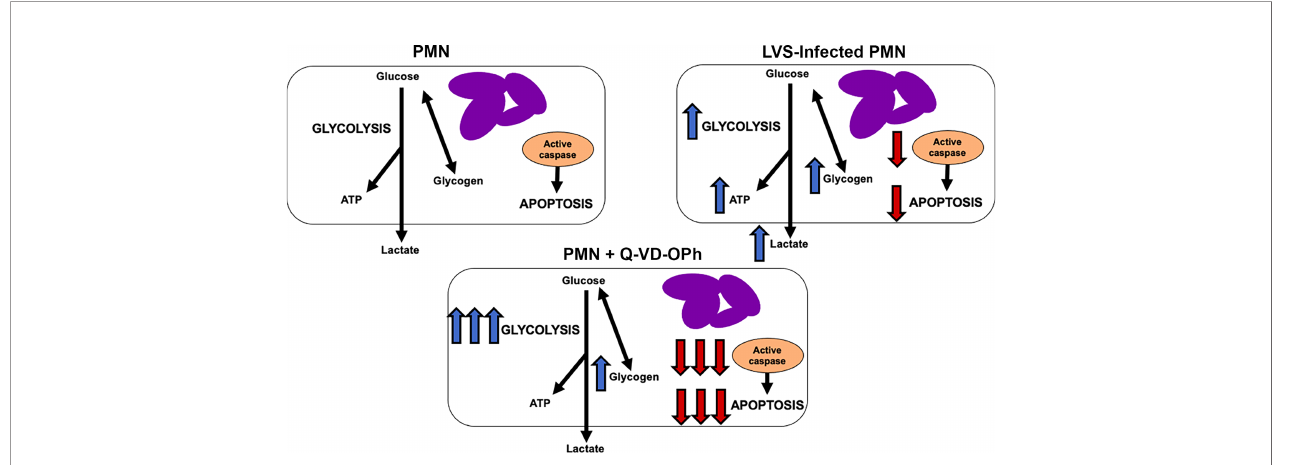
FIGURE 10 | Model. Effects of F. tularensis and Q-VD-OPh on neutrophil metabolism. See Discussion for